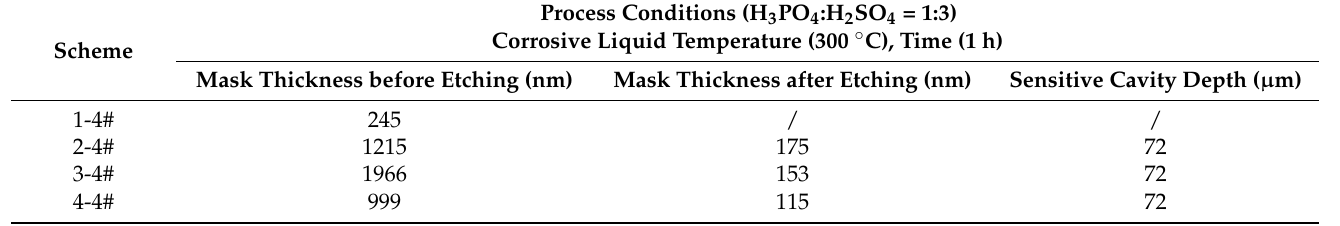
Table 5. Process results at 300 ◦ C.